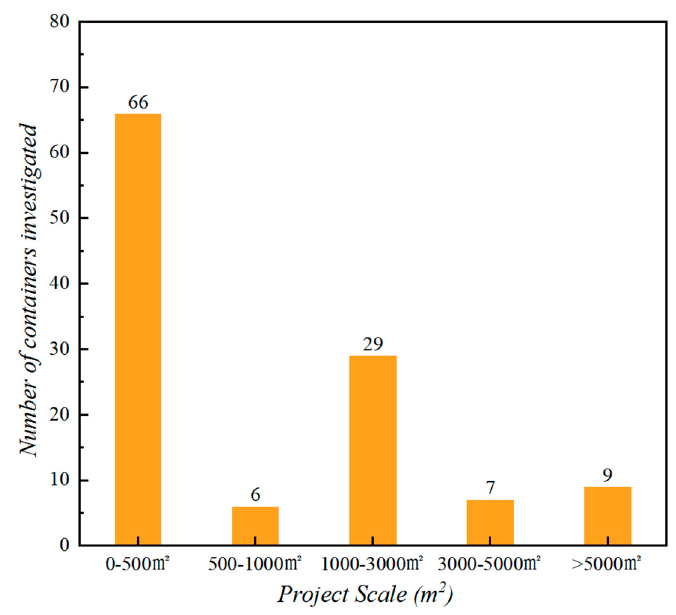
Figure 6. Project scale statistics of investigated container project cases around China.